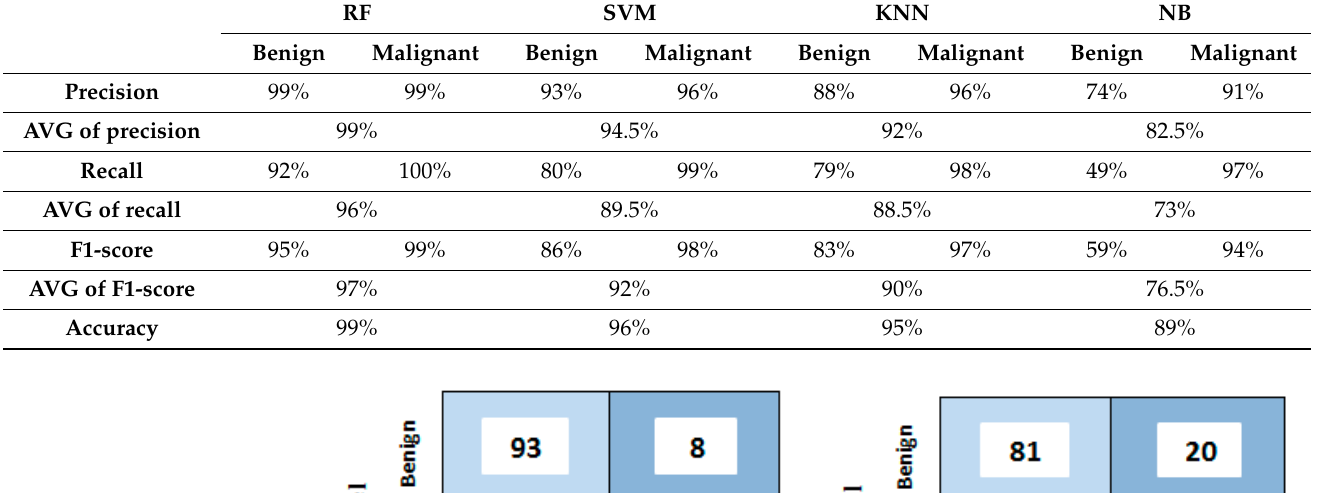
Table 4. The performance metrics for different classification techniques before using grey wolf optimization algorithm.